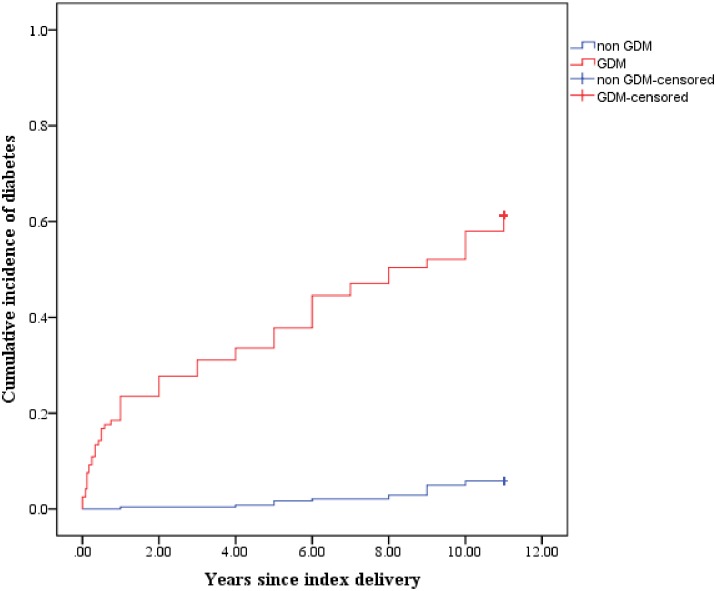
Cumulative incidence of T2DM in the GDM and non GDM groups.